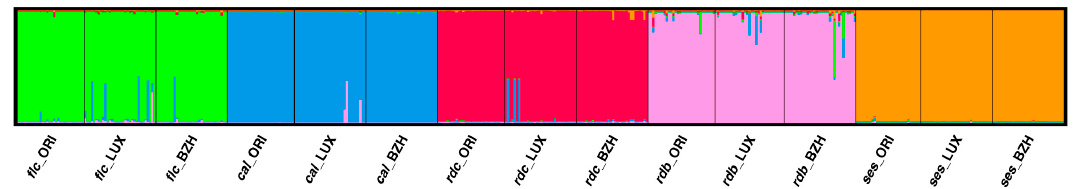
Figure 4. Genetic relationships among the 15 populations of common bean estimated using InStruct software. Each individual is represented by a vertical column divided into K colored segments. The length of each segment indicates the proportions of the genome attributed to the different clusters.